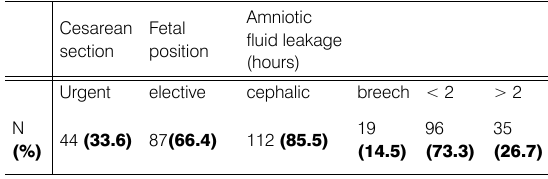
Table 1. Percentage of urgent CS, fetal breech positions and PROM >2 hours.